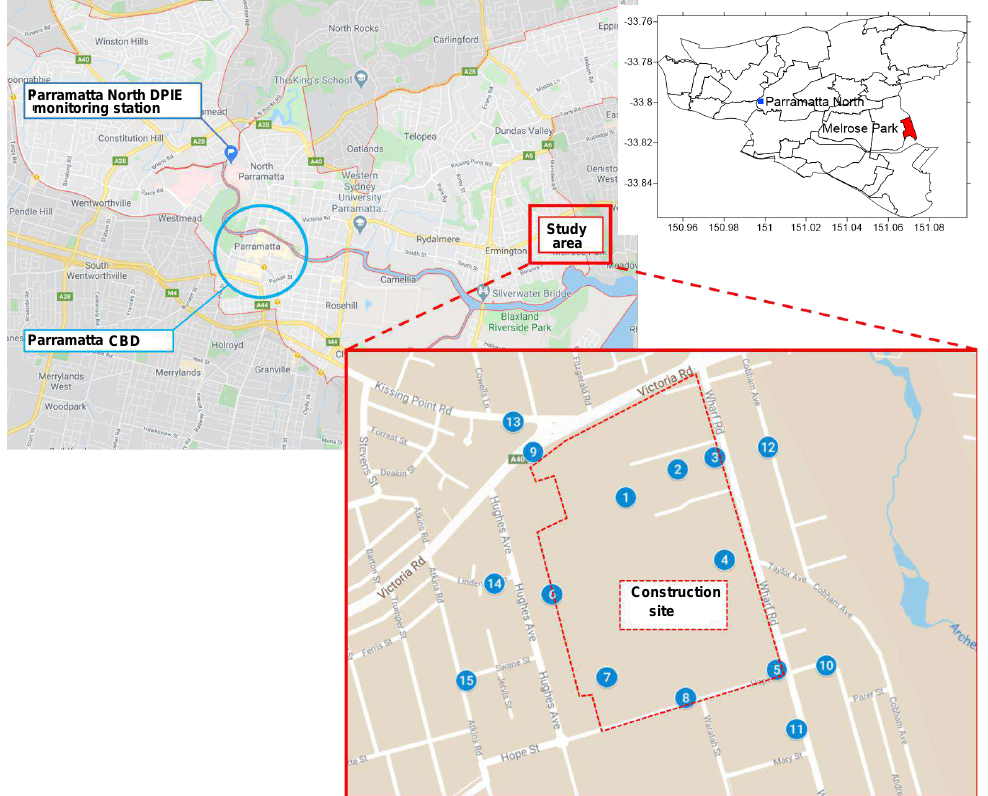
Figure 3. Map showing EMS deployments relatively to a closest monitoring station.